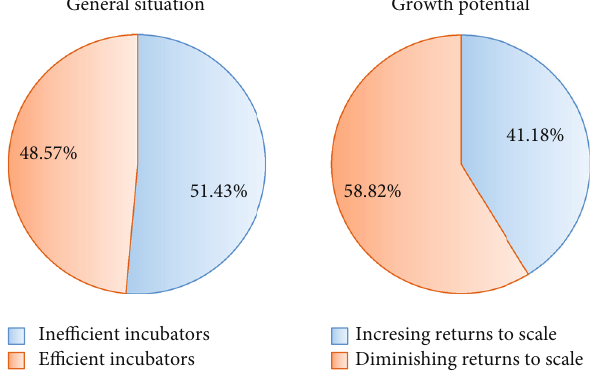
Figure 5: Results of general situation and growth